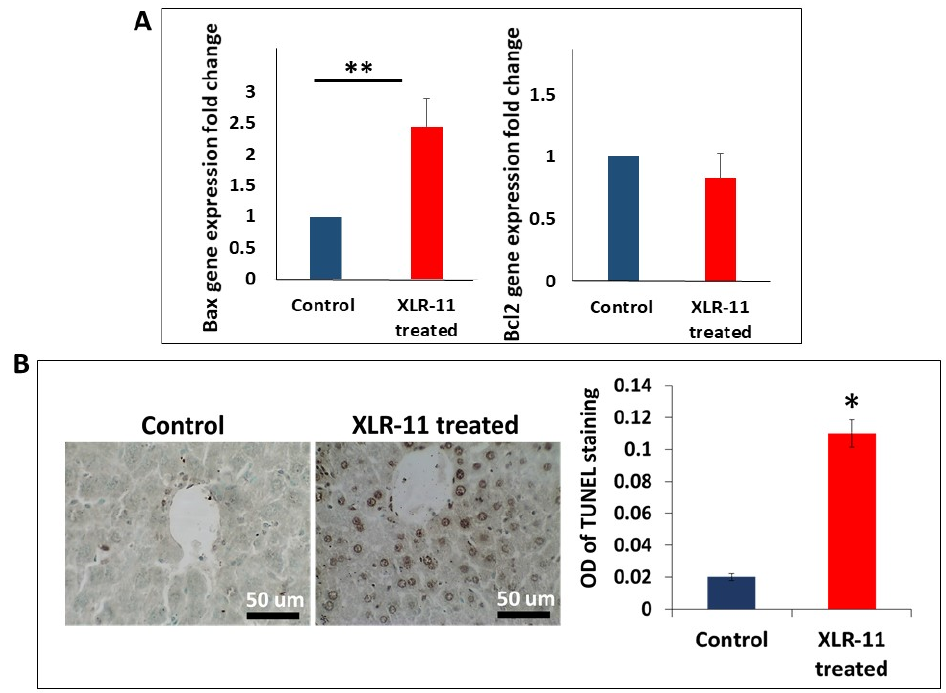
Figure 3. ( A ) Gene expression of markers of apoptosis Bax and Bcl2 in liver of XLR-11 treated mice compared to control mice, ( B ) TUNEL staining of the liver of XLR-11 treated mice compared to control mice, of * p ‐ value < 0.05, ** p ‐ value < 0.005, respectively.